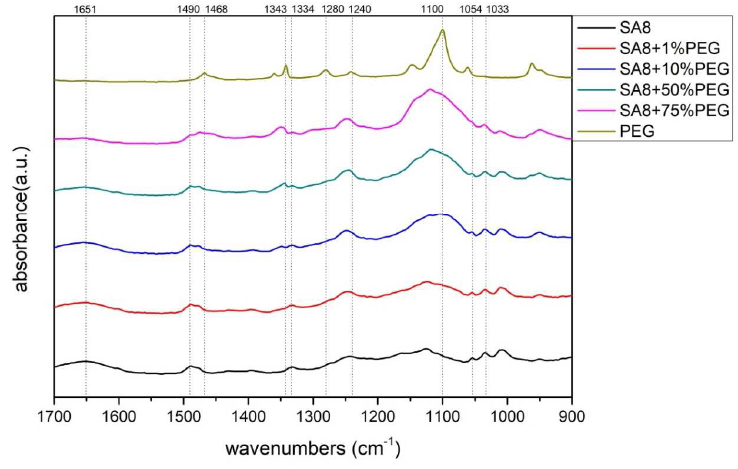
Figure 5. Fourier-transform infrared spectroscopy (FT-IR) spectra of SA8 blended with PEG series at 1700–900 cm −1.